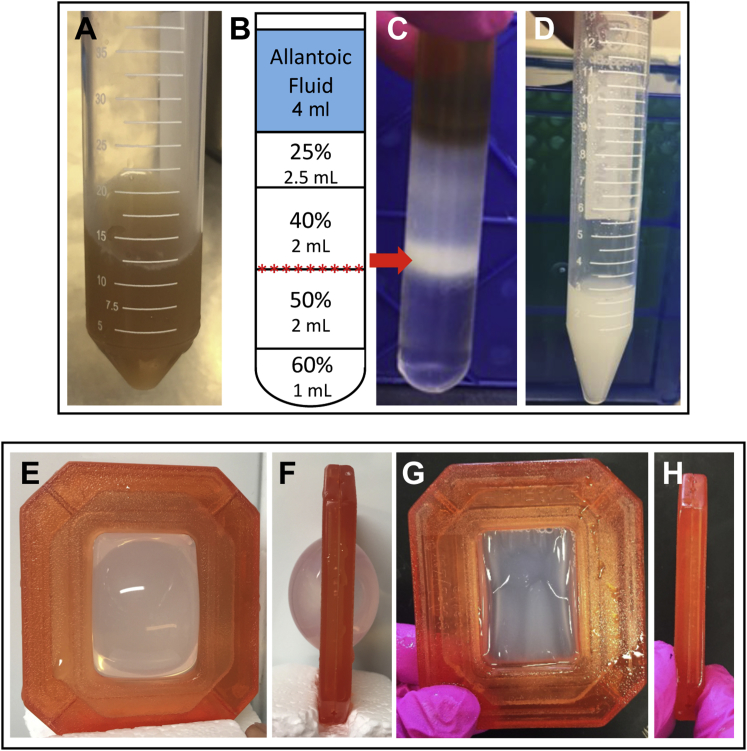
Gradient Ultracentrifugation and PEG Precipitation of NDV after TFF(A) Concentrated allantoic fluid after tangential flow filtration. Fluid appears murky brown because of the concentrated nature of the sample. (B) Schematic of sucrose gradient setup. Red stars indicate where NDV will band after ultracentrifugation. (C) Example of sucrose gradient after ultracentrifugation. NDV is typically located in the opaque white band between 40% and 50% sucrose. (D) Pooled virus recovered from the sucrose gradient. (E) Front and (F) side view of 10K MWCO Slide-A-Lyzer cassette filled with purified NDV, which has increased 3-fold in size after three buffer exchanges in PBS. (G) Front and (H) side view of dialysis cassette after being incubated in 40% polyethylene glycol 20,000 (PEG-20) for 2.5 hr.